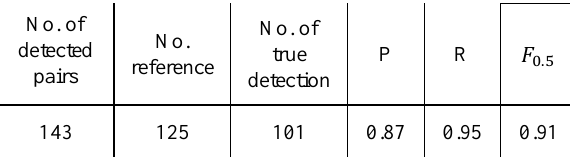
Table 2. Statistical evaluation of the detected matching pairs